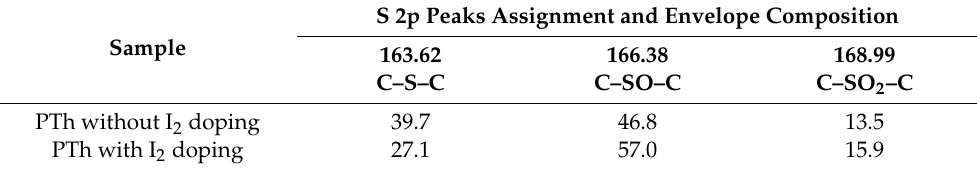
Table 2. Peak assignment (BE, eV) and envelope composition (%, total = 100) of various C 1s core level spectra of PTh films observed in XPS in Figure 3b. Table 4. Peak assignment and envelope composition of various O 1s core level spectra of PTh films observed in XPS in Figure